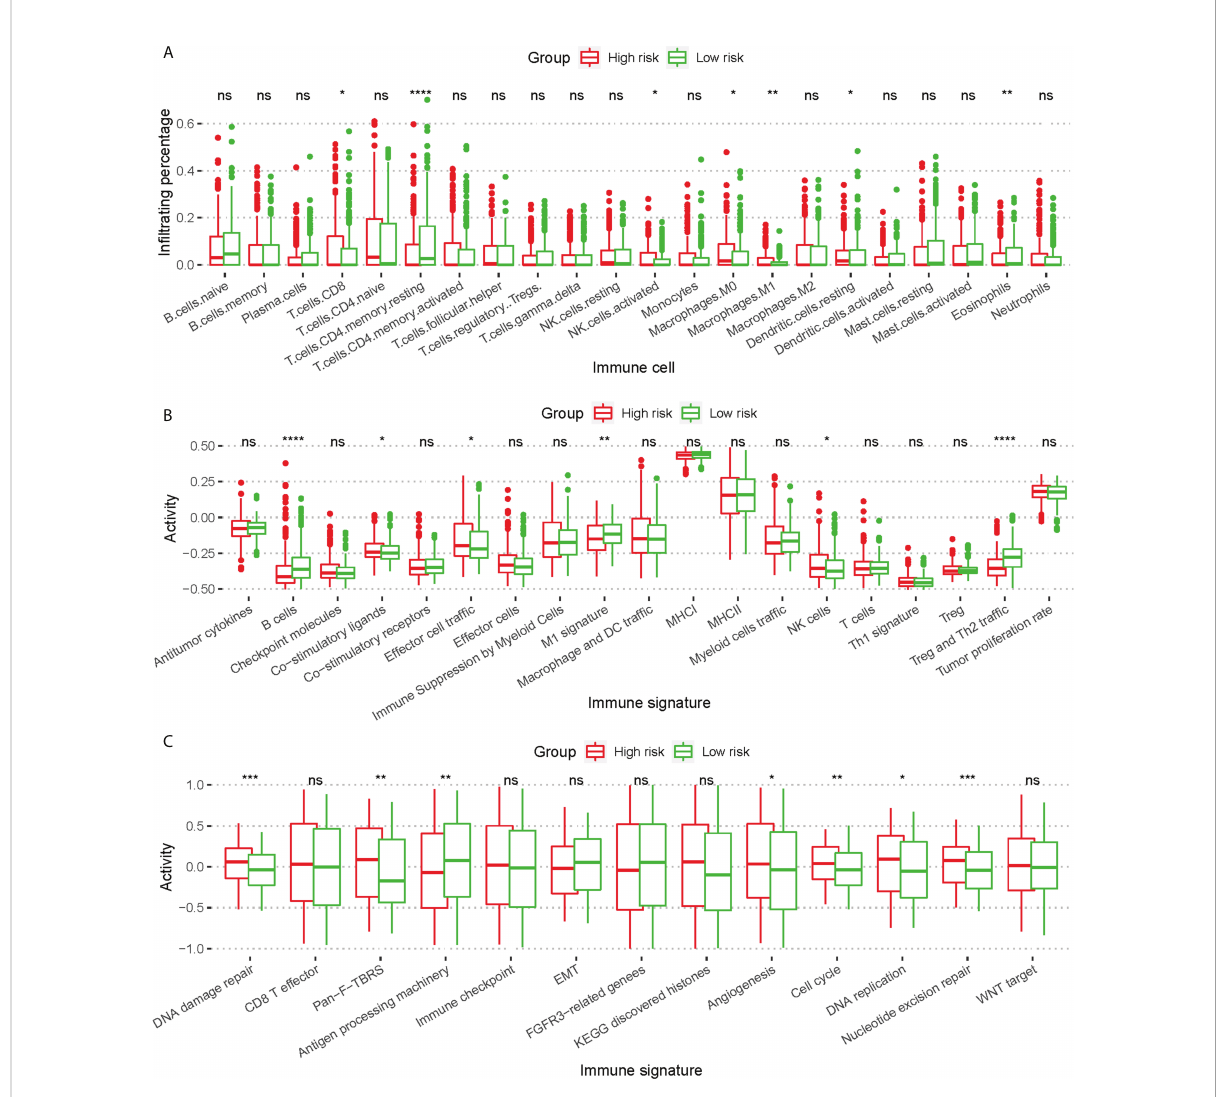
FIGURE 5 Difference of immune cell in fi ltration and immune signature activity between high risk patients and low risk patients. (A) Box plot for comparing the in fi ltration percentage of 22 immune cells; immune cell in fi ltration has been evaluated by CIBERSORT. (B, C) Box plot for comparing the activity of immune signature. In (A – C) , * P < 0.05; ** P < 0.01; *** P < 0.001; **** P < 0.0001; ns, not signi fi cant (Kruskal-Wallis